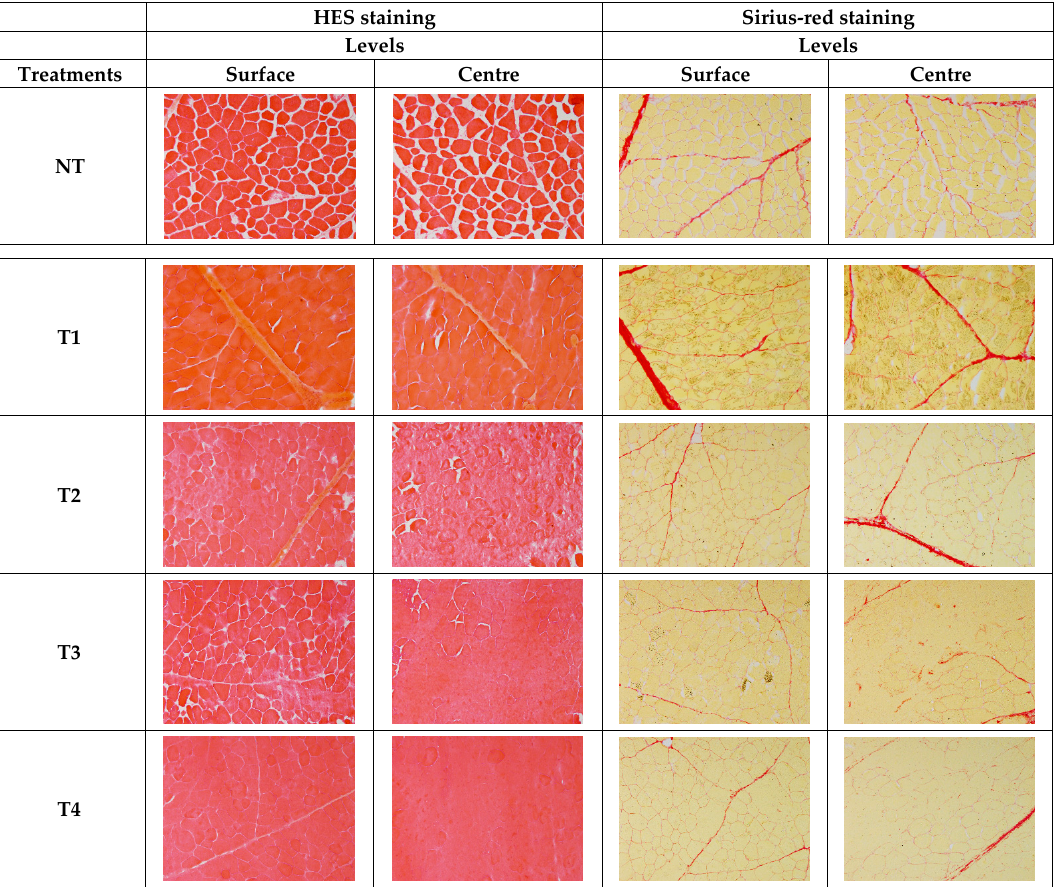
Figure 3. ( A ) Stress values measured at a compression rate of 20% and ( B ) stress values measured at a compression rate of 80% on raw beef Semitendinosus meat pieces submitted to five different mechanical treatments: NT (control, no mechanical treatment applied), T1 (2500 compression cycles, about 3 h), T2 (6000 compression cycles, about 7.5 h), T3 (9500 compression cycles, about 12 h) and T4 (13,000 compression cycles, about 16 h). Data are expressed as mean +/ − standard error calculated from 300 individual samples prepared from three different meat pieces. Means with different letters (a–d) are significantly different ( p < 0.05) according to the Tukey test.